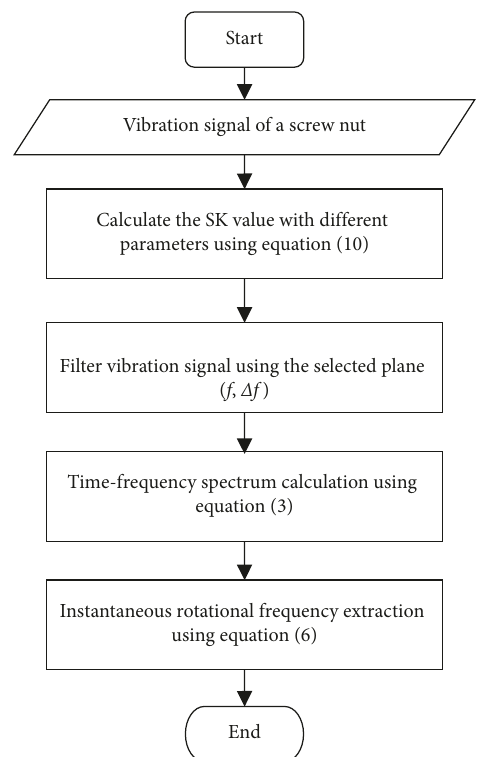
Figure 4: Flowchart of the proposed instantaneous rotational frequency extraction